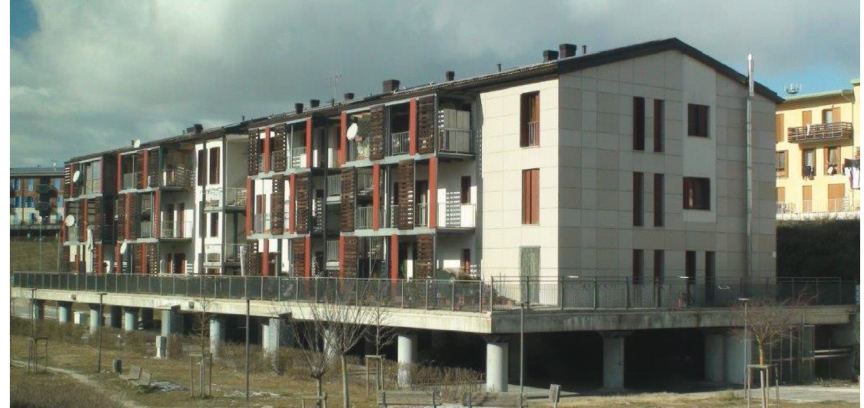
Figure 19: The building at L’Aquila, seismically isolated by means of CSSs, deployed at the top of the circular columns, which raise up from the